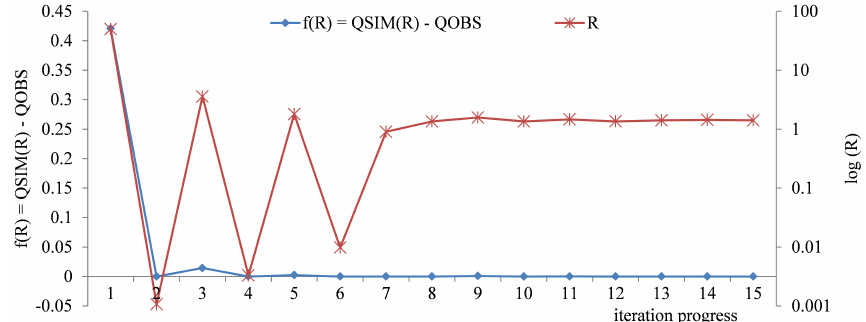
Figure 2. Illustration of the iteration progress for one model time step. Note that the right y axis showing the inverse rainfall values ( R ) is in a logarithmic scale (units in mmh − 1